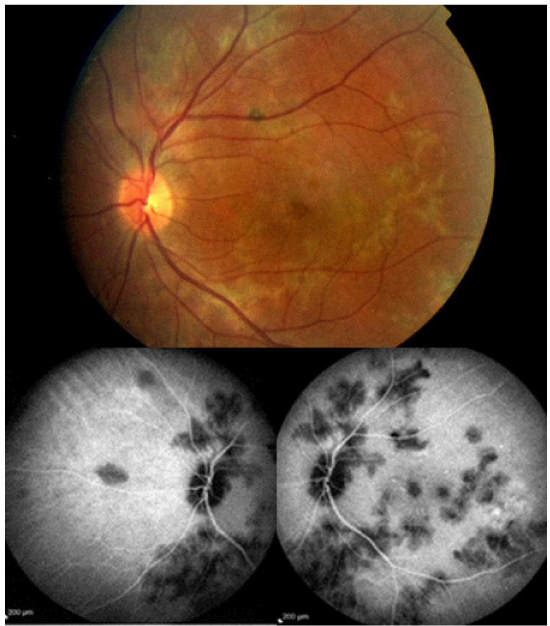
Figure 26. Case of Amppiginous Choroiditis. Disease started as APMPPE/AMIC lesions but progressed to become confluent resembling more serpiginous choroiditis. Extensive scarring was also more characteristic of